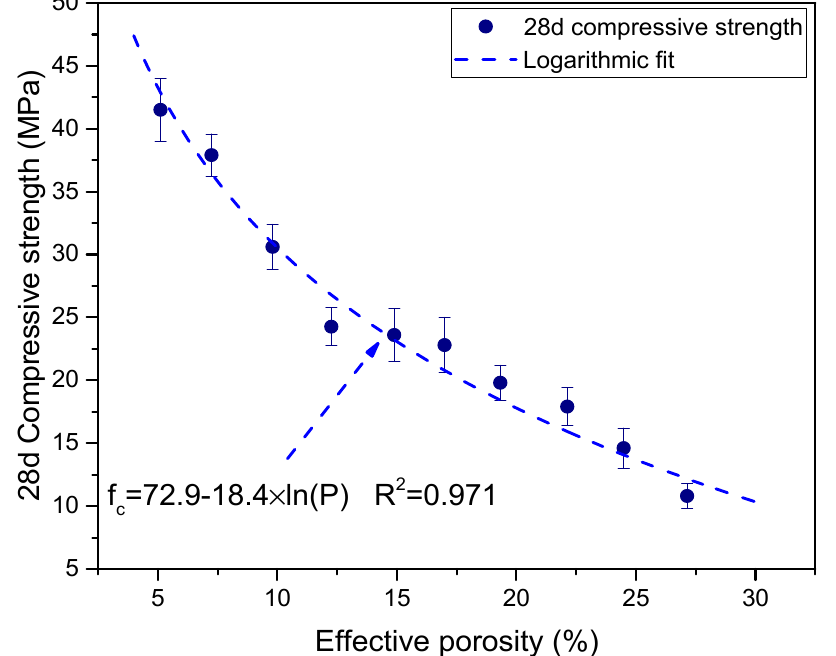
Figure 8. The 28 d compressive strength of the pervious concrete and its relationships versus the effective porosity.